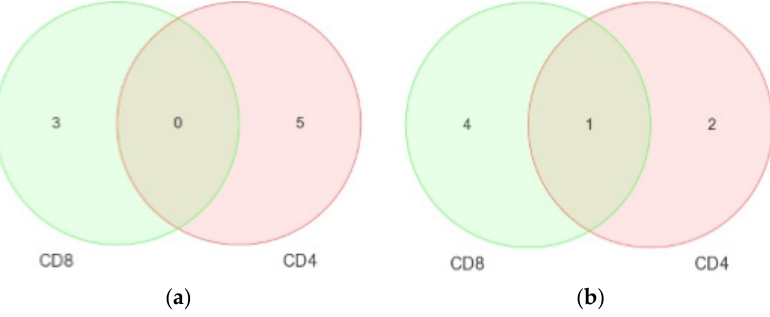
Figure 12. Venn diagrams showing DE miRNAs in the CD4+ and CD8+ cells of viremic ( a ) and LTNP ( b ) disease groups. FDR method with p < 0.05 was used.